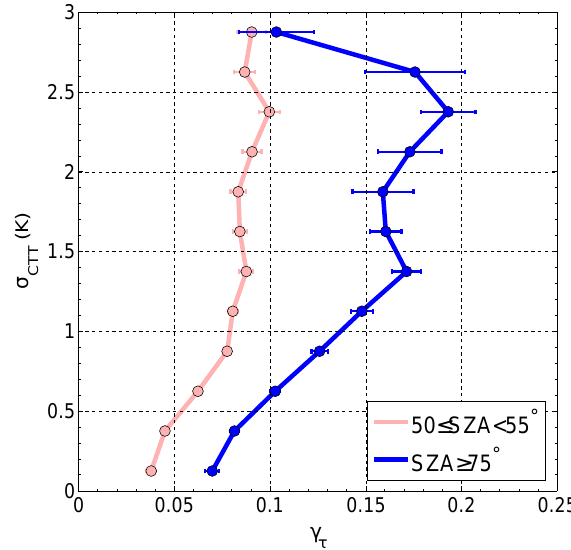
Figure 14. Mean γ τ for each σ CTT bin from Fig.